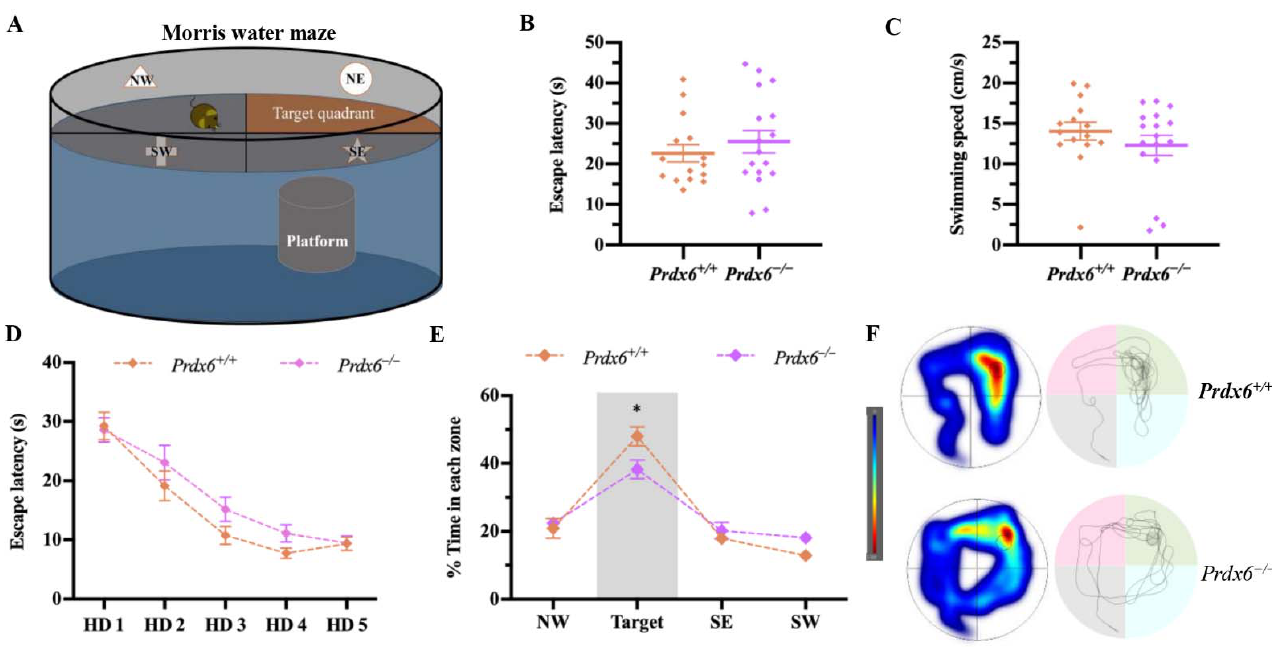
Figure 5. The female Prdx6 − / − mice showed impaired spatial memory in the Morris water maze (MWM) task. ( A ) Illustration of a MWM. ( B ) Escape latency (time to reach the platform) and ( C ) swimming speed during the visible platform trial ( Prdx6 +/+ , n = 15 and Prdx6 − / − , n = 17). ( D ) The trial plots of escape latency for 5 days of hidden trials. ( E ) Percentage of time spent in each quadrant during a probe test. ( F ) The heat map (left panel) and swimming pattern (right panel) during a probe test. All data are presented as mean ± SEM, * p < 0.05, mixed-design repeated measure ANOVA followed by Bonferroni ’s post hoc test with unpaired Student’s t test for individual differences between groups within each quadrant. NW, northwest; NE, northeast; SW, southwest; SE, southeast; PRDX6, peroxiredoxin 6; HD, hidden platform day.